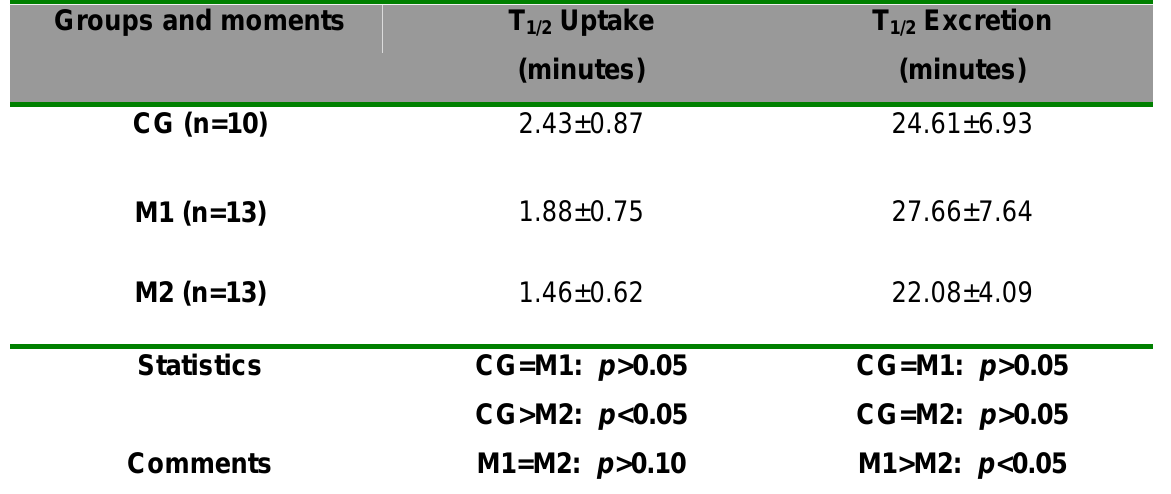
Table 3: T uptake and T excretion (X±SD) of DISIDA [ 99mm Tc] of controls (CG) 1/2 1/2 and patients with pulmonary tuberculosis at both study moments (M1, before triple treatment; M2, two months after treatment